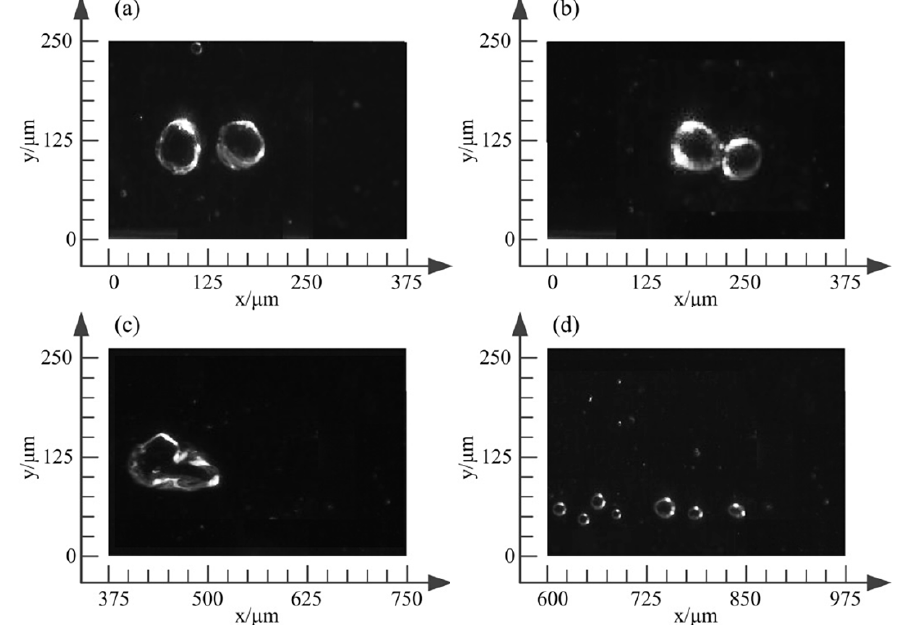
Figure 18. Experimental results of double bubble bursting near the wall at di ff erent times: ( a ) t = 16 µ s, ( b ) t = 130 µ s, ( c ) t = 150 µ s, ( d ) t = 260 µ s.